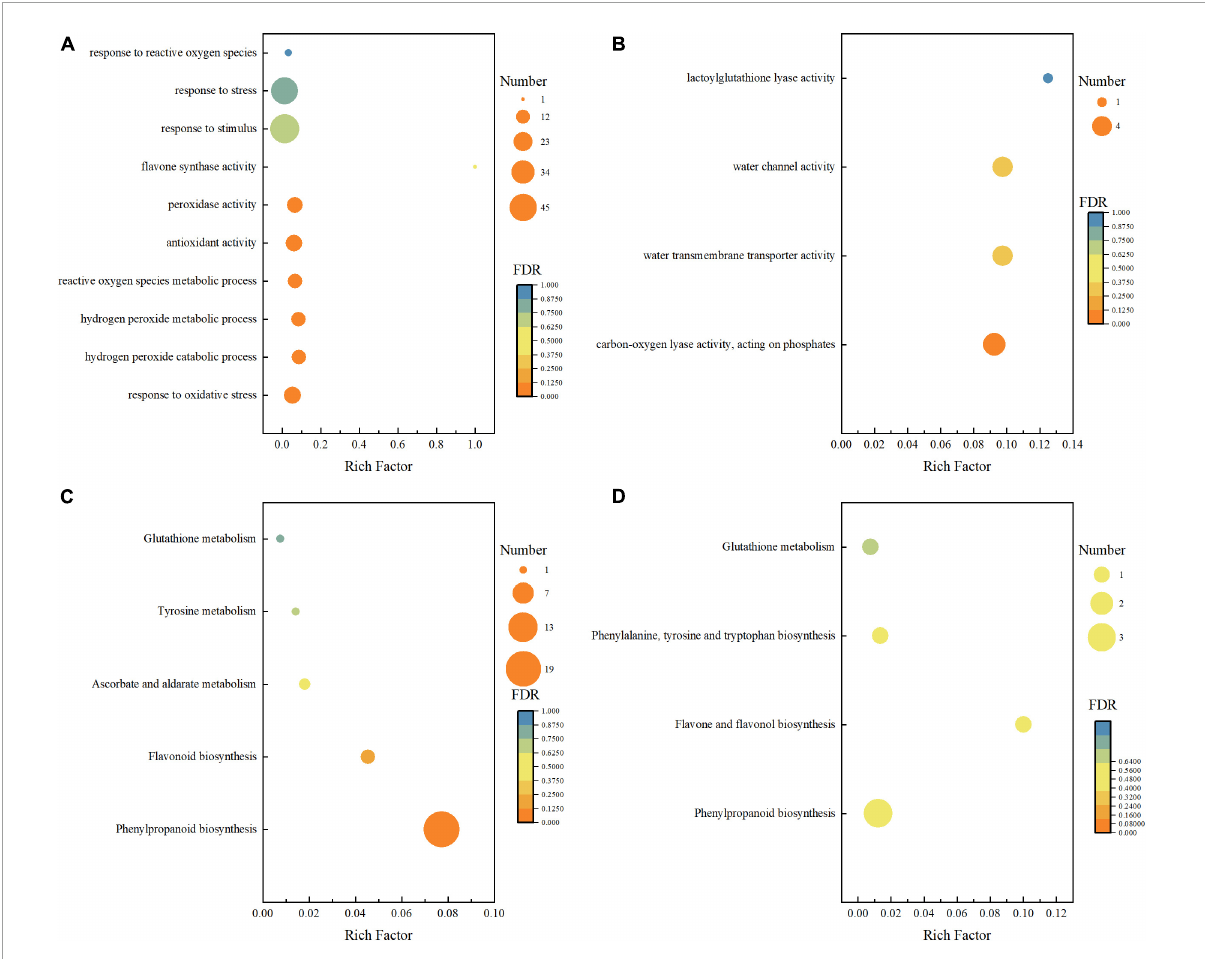
FIGURE6 Enrichment analyses of differential expression genes among control, BR, and Pcz. (A) , GO enrichment analyses in control and BR groups. (B) , GO enrichment analyses in control and PCZ groups. (C) , KEGG enrichment analyses in control and BR groups. (D) , KEGG enrichment analyses